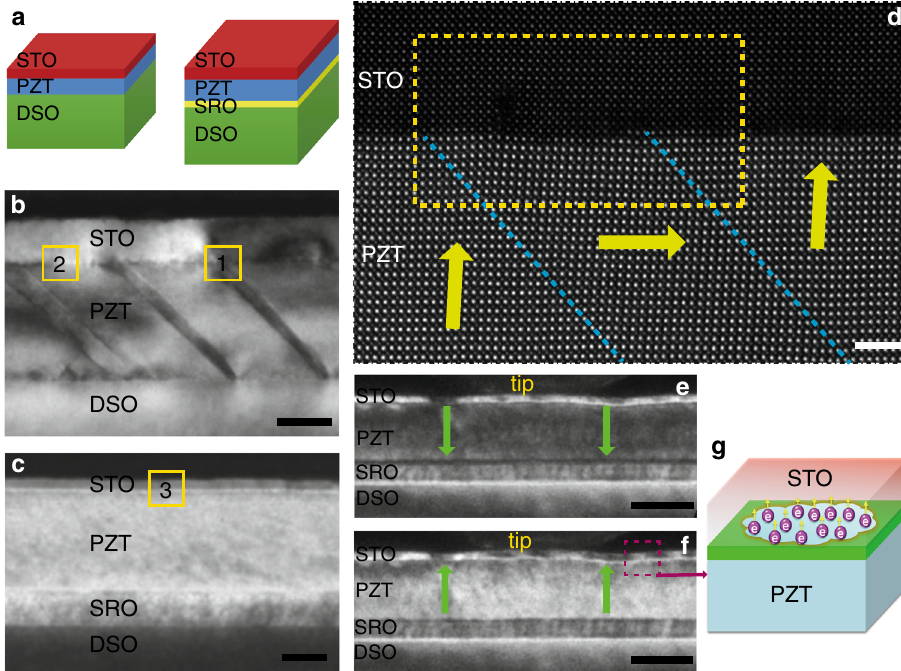
Fig. 1 Structural characterization and in situ domain switching. a Schematics of the STO/PZT/DSO (left) and STO/PZT/SRO/DSO (right) heterostructures. b Low-magni fi cation TEM image shows repeating 90° domain walls in the PZT layer in a STO (20 nm)/PZT (50 nm)/DSO sample. Scale bar, 20 nm. c Low-magni fi cation TEM image of STO (5 nm)/PZT (50 nm)/SRO(20nm)/DSO sample. The PZT layer is single-domain with SRO as the bottom electrode. Scale bar, 20 nm. d HAADF STEM image shows a subarea on the STO/PZT interface marked in the box number 1 in b ). The 90° domain wall highlighted by the blue dashed lines. The green arrows indicate the polarization directions determined by the lead displacement vectors D Pb . Capacitor like domain switching in STO/PZT/SRO/DSO structure by in situ TEM. Capacitor like domain switching in STO/PZT/SRO/DSO structure by in situ TEM. Scale bar, 2 nm. e Dark- fi eld TEM image shows a single-domain structure (downward polarization) at the initial state. Scale bar, 50 nm. f Capacitor-like domain switching occurs when a 0 → − 6 V DC voltage is applied by tungsten tip. Scale bar, 50 nm. g The sketch of SP-2DEG induced at the interface of